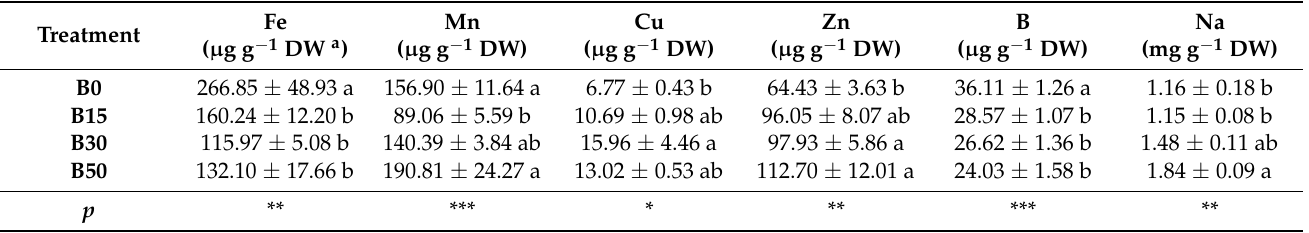
Table 8. Micronutrient (Fe, Mn, B, Zn, Cu) and Na detected in shoots of lettuce grown on different biochar:peat